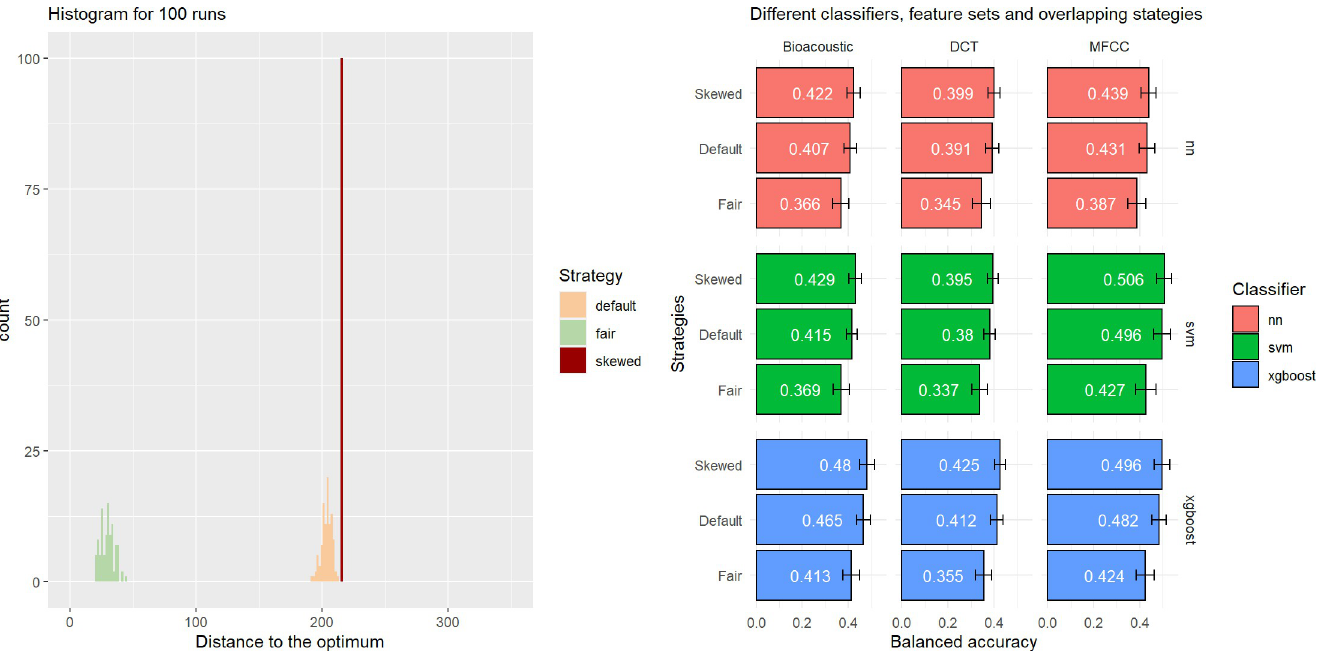
Fig 13. Influence of the sampling on data leakage (sequences with at least three calls considered). Three scenarios are applied: Default , Fair and Skewed . Left. Distribution of the 100 runs for each strategy in terms of sequence overlap between training and test sets (0: no overlap). Right. Influence of strategy on performance (balanced accuracy) for each combination of classifiers and acoustic feature sets when classifying individual